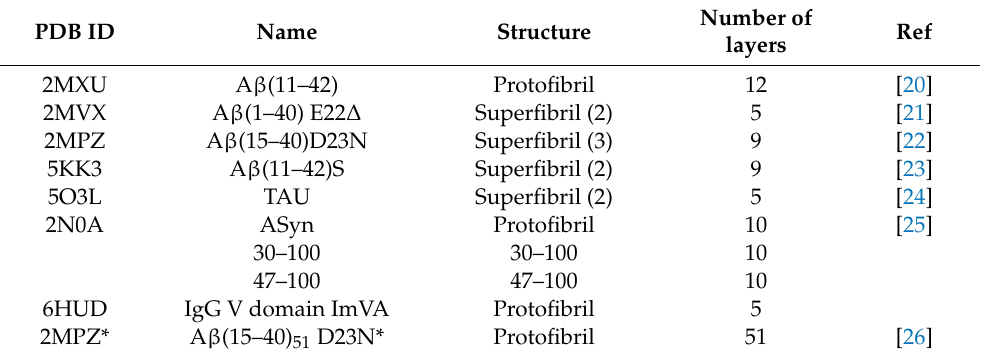
Table 7. List of amyloids analyzed in the present work. The composition of superfibrils, if applicable, and the number of protofibrils in superfibrils, if applicable, (number in parentheses) are given. The number of "floors" (layers) in the super- and protofibril construction is also given. 2MPZ*